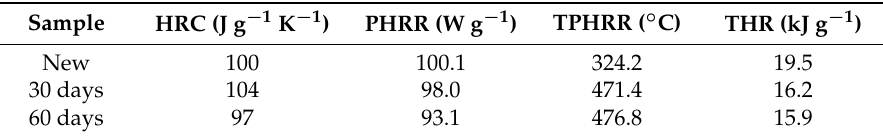
Figure 8. Integral HRR (total heat release (THR)) of PVC sheaths for new and aged cables.